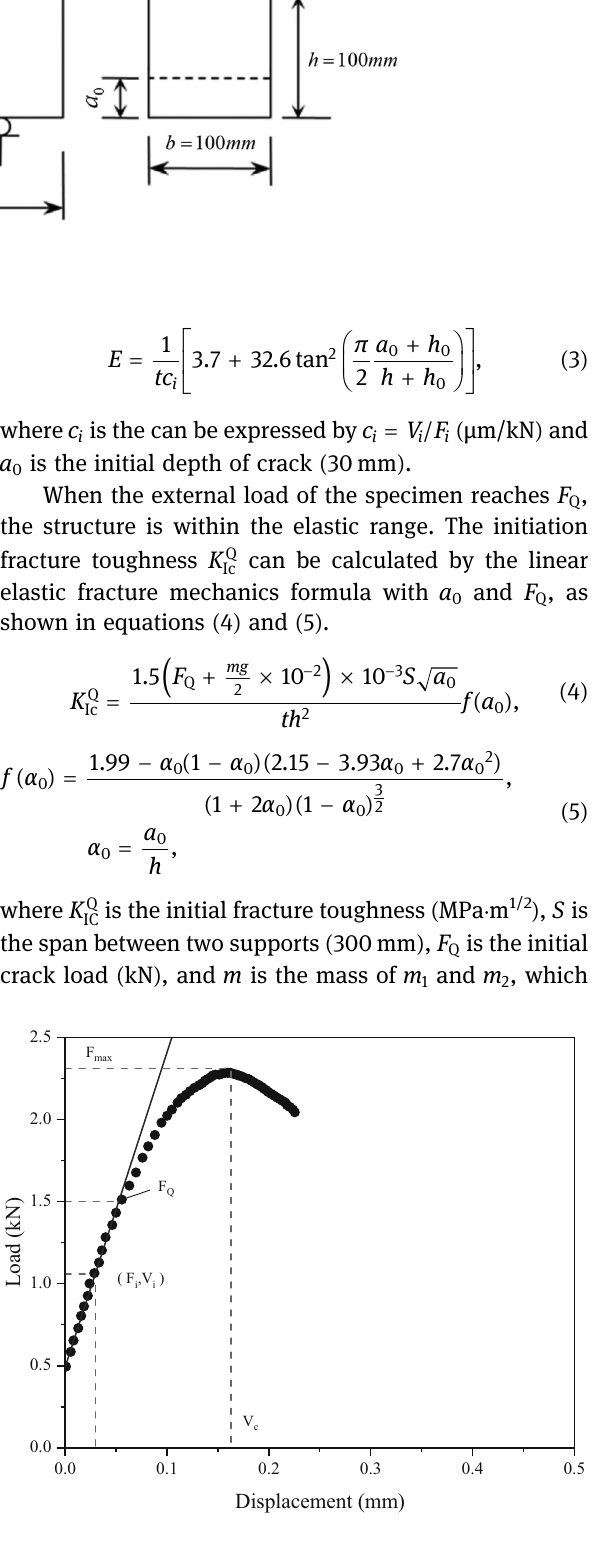
Figure 6: Load – crack opening